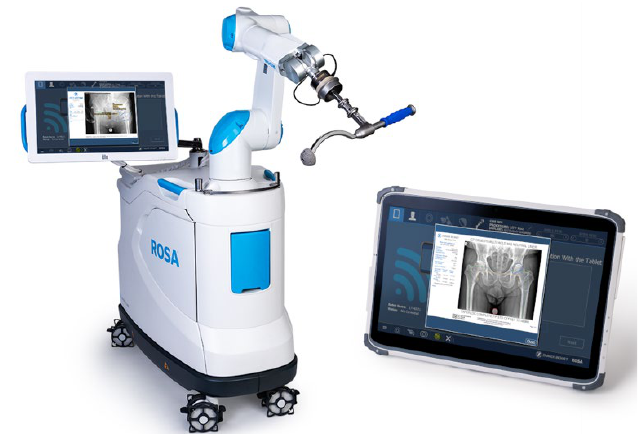
Figure 2. ROSA system including example of planning system.